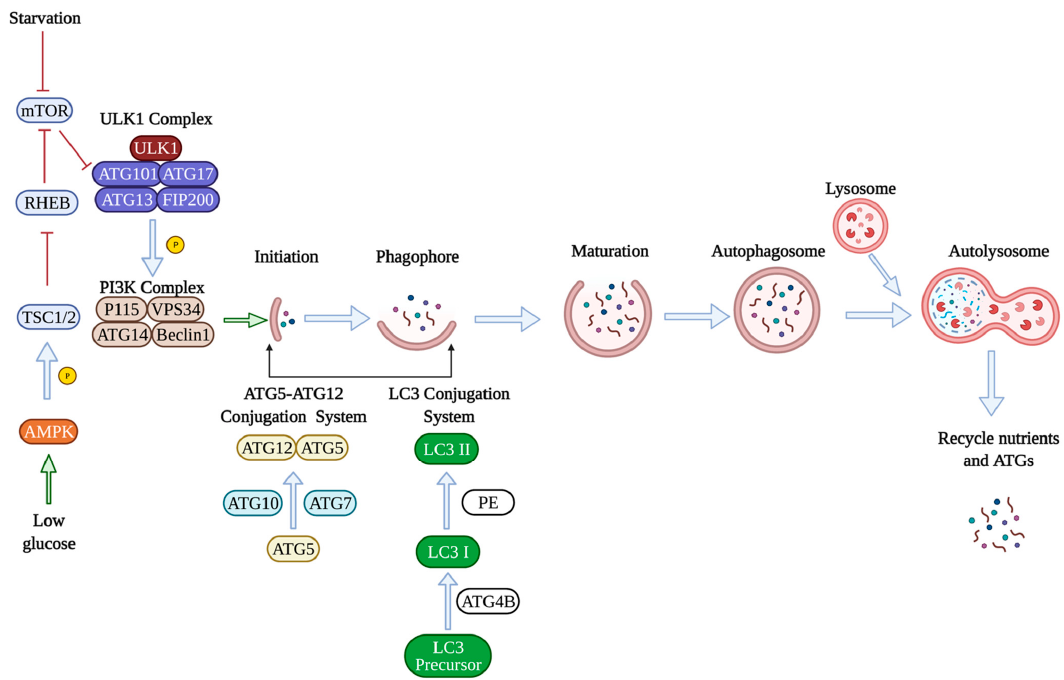
Figure 1. Molecular mechanisms of autophagy. Under nutrient-rich conditions, the mammalian target of rapamycin (mTOR) inhibits autophagy by inhibiting the unc-51-like kinase 1 (ULK1). The ULK1 complex consists of autophagy-related genes ATG101, ATG17, ATG13, and FIP200, which is a focal adhesion kinase bound to ULK1. ULK1 then phosphorylates other proteins, such as the class III phosphatidykinositol-3-kinase (Ptdlns3K) complex, which consists of vacuolar protein sorting 34 (VPS34), ATG14, Beclin1, and P115 protein. Adenosine monophosphate-activated protein kinase (AMPK) is another protein involved in autophagy induction. Under glucose deprivation, AMPK phosphorylates the tuberous sclerosis complex (TSC1/2), inactivates RHEB, which is a GTPase activating protein, and inhibits mTOR leading to autophagy induction. The formation and elongation of the autophagosomes involve two ubiquitin-like conjugation systems. The first conjugation system is the ATG5-ATG12 conjugation system formed by the protein ATG5 conjugating to ATG12 with the ubiquitin-like enzymes ATG7 and ATG10, which promotes the elongation of the autophagosomal membrane. The second conjugation system involves microtubule-associated protein 1 light chain 3 (LC3). LC3 is cleaved by the protease ATG4B into its mature form LC3-I, conjugating with phosphatidylethanolamine (PE) to form the lipidated version LC3-II. Finally, autophagosomes fuse with the lysosome to degrade the cargo by the lysosomal enzymes. Nutrients and ATGs are recycled for future use. Green arrows mean activate/promote, blue arrows indicate normal physiological processes, red means